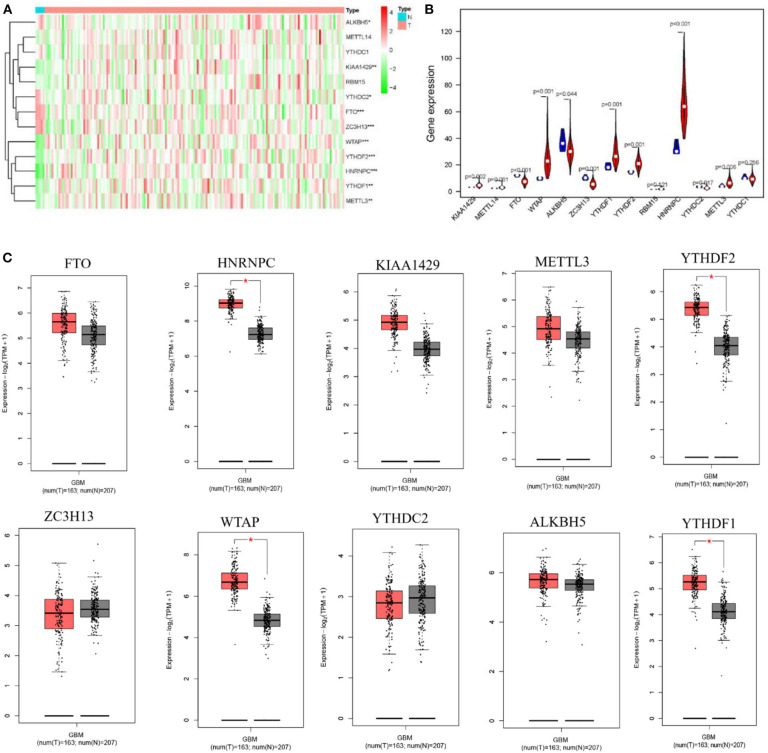
Expression of m6A RNA methylation regulators in GBM and normal tissue. (A,B) The heatmap and the violin diagram showed the m6A RNA methylation regulators in GBM and normal tissues. GBM was marked with red and normal tissues were marked with blue, position of white spots on the way represented the median value of expression. (C) The boxplots structured by GEPIA showed a difference between GBM and large number of normal brain tissues. The num(T) represented the number of tumors which were marked with red, the num(N) represented the number of normal tissues which were marked with blue (p < 0.001 noted with ***p < 0.01 noted with **p < 0.05 noted with *).